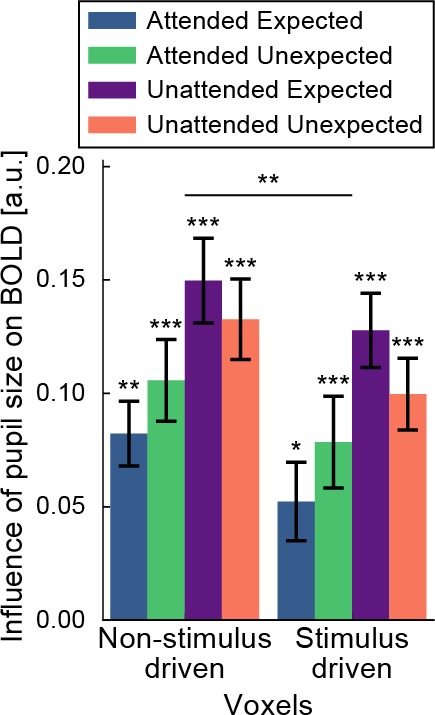
Pupil dilation influences BOLD responses more in non-stimulus-driven than stimulus-driven V1 voxels.Displayed are the parameter estimates of the influence of pupil size on BOLD responses in V1. BOLD responses increase with larger pupil dilation. This association was stronger in non-stimulus-driven (left) than stimulus-driven (right) V1 gray matter voxels. Error bars indicate within-subject SEM.*p<0.05, **p<0.01, ***p<0.001.